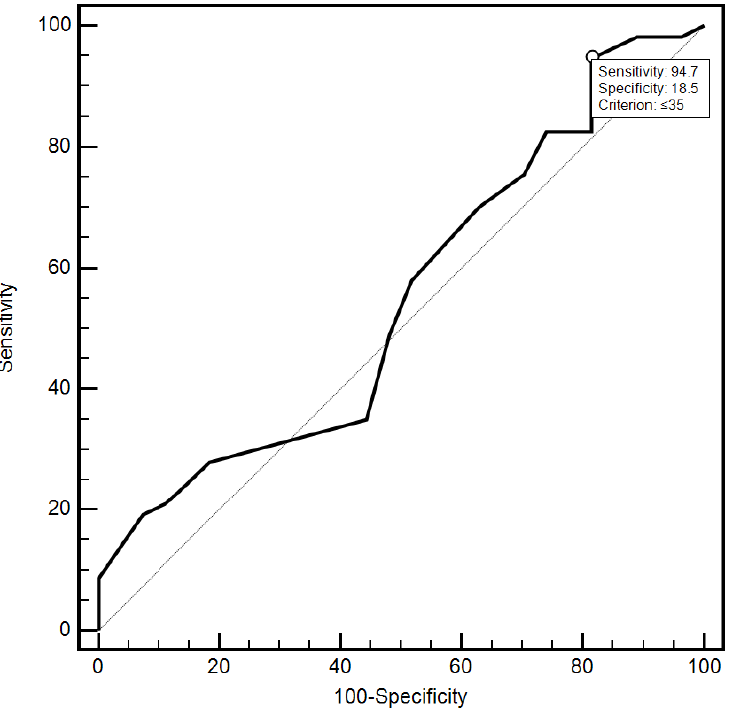
Figure 6. Diagnostic usefulness of the age parameter in the early detection of preterm labor using the ROC